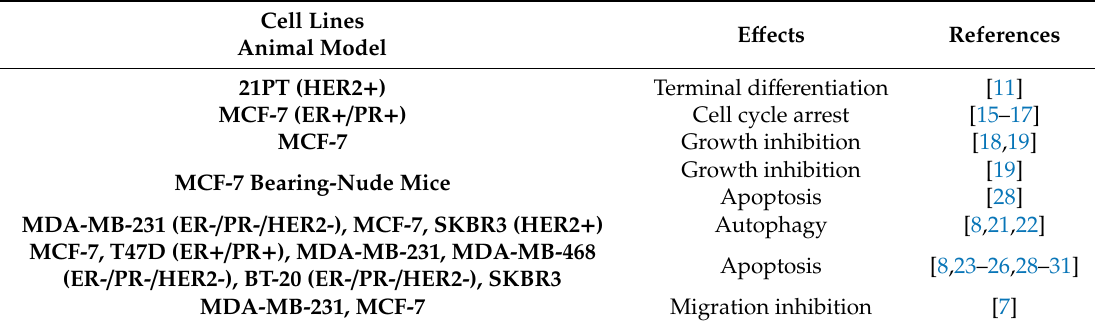
Table 1. ‘In vitro’ and ‘in vivo’ studies showing the e ff ects of proliferator-activated receptor γ (PPAR γ ) activation in breast